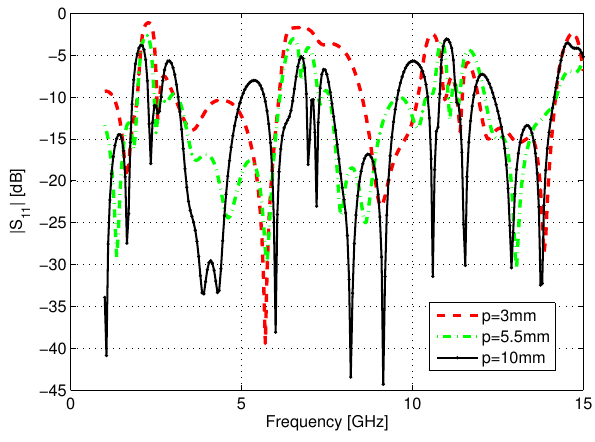
Figure 7: S-Parameters of the three-cell structure with p =5.5mm.